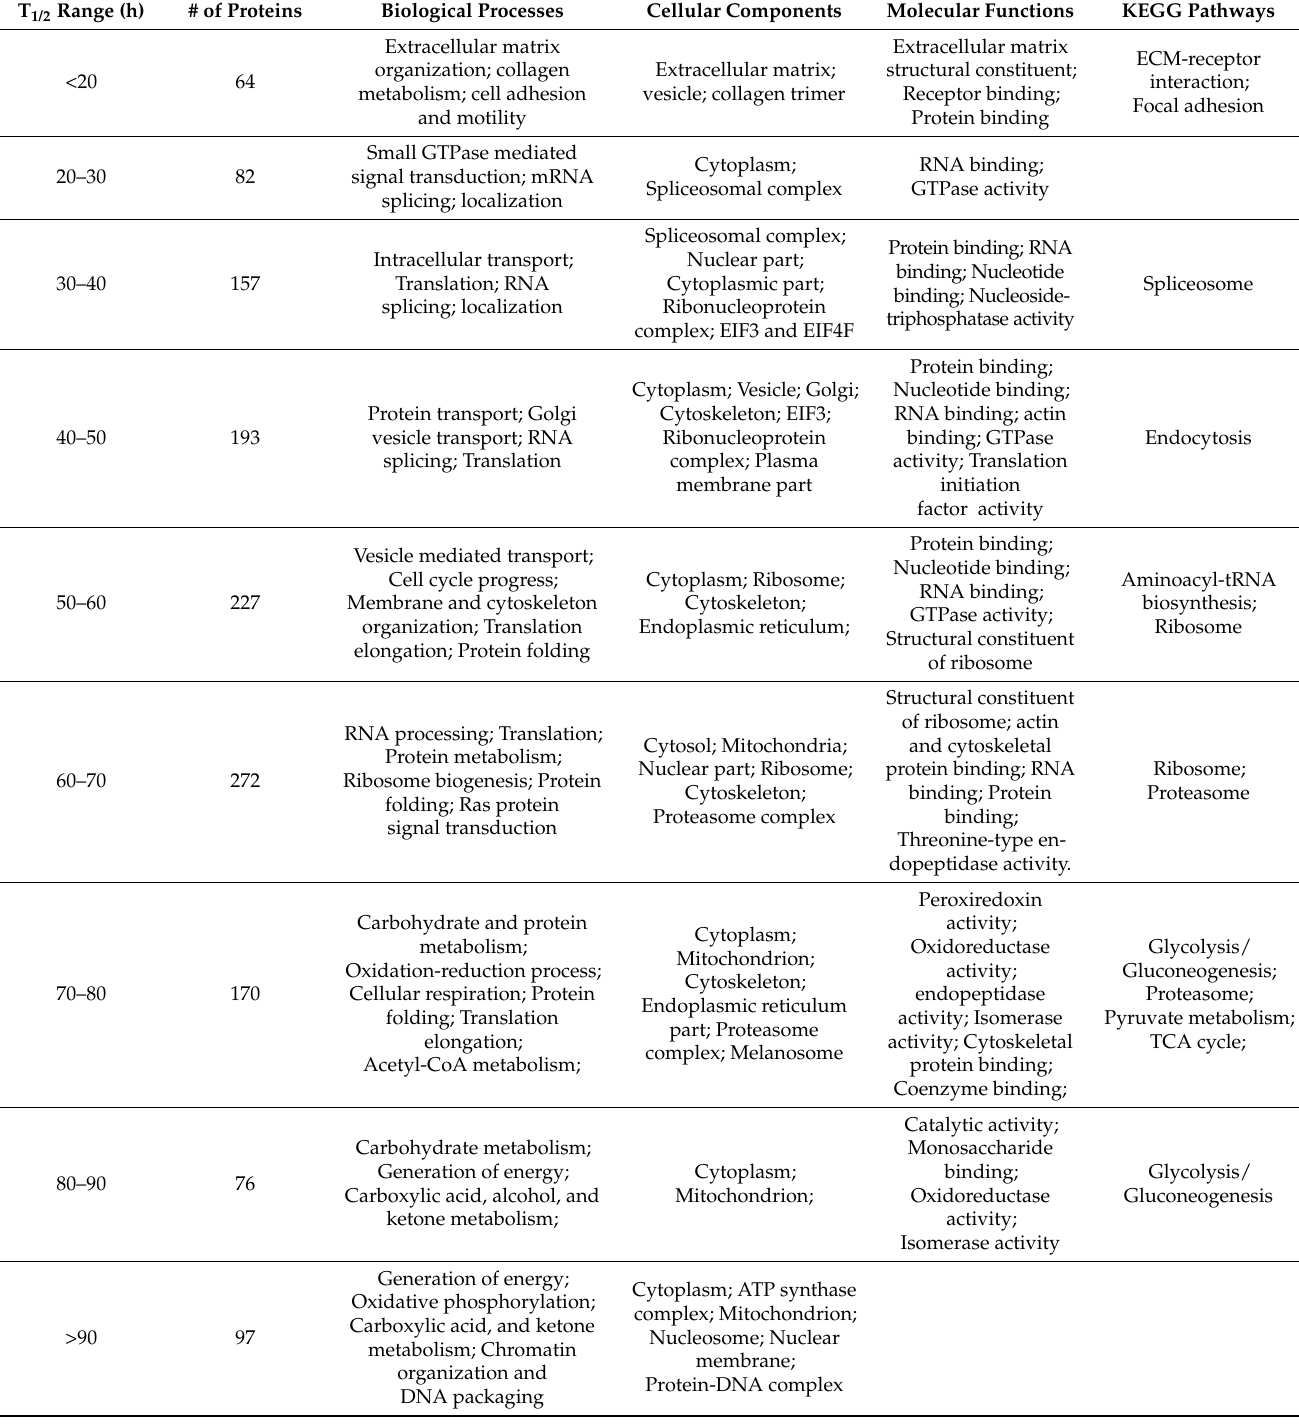
our estimation of protein expression data for 1801 proteins spans four orders of magnitude. Table 4. Gene Ontology annotation of proteins grouped according to their average half-life. Proteins are grouped in 9 arbitrary ranges of half-life, and the most enriched and significant GO terms (Biological Process, Cellular Component, Molecular Function, and KEGG pathways) are listed for each